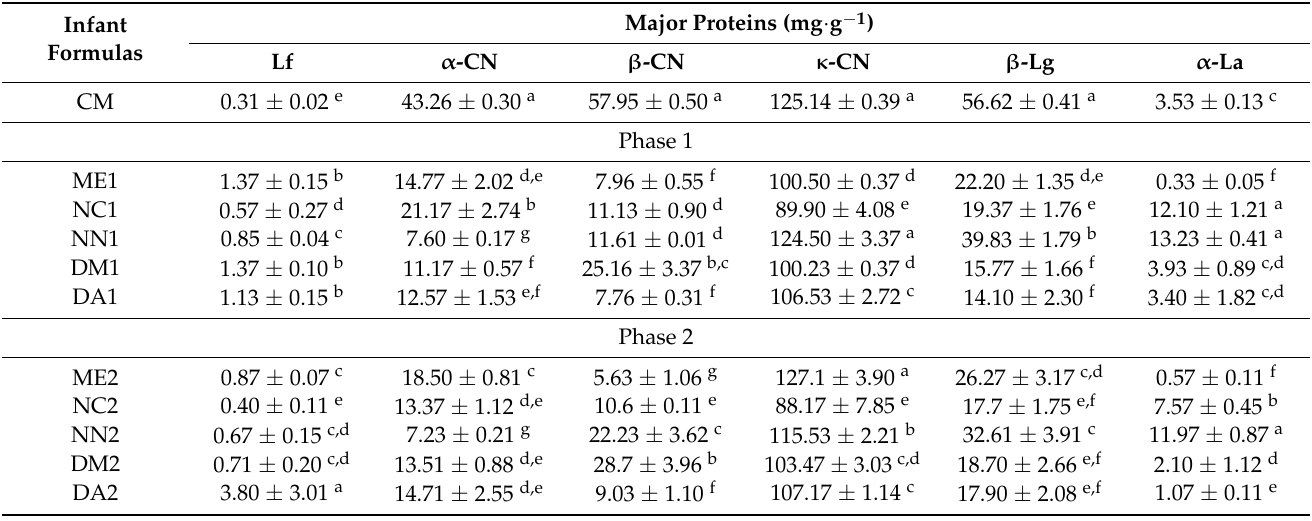
Table 1. Major protein contents in phase 1 and phase 2 infant